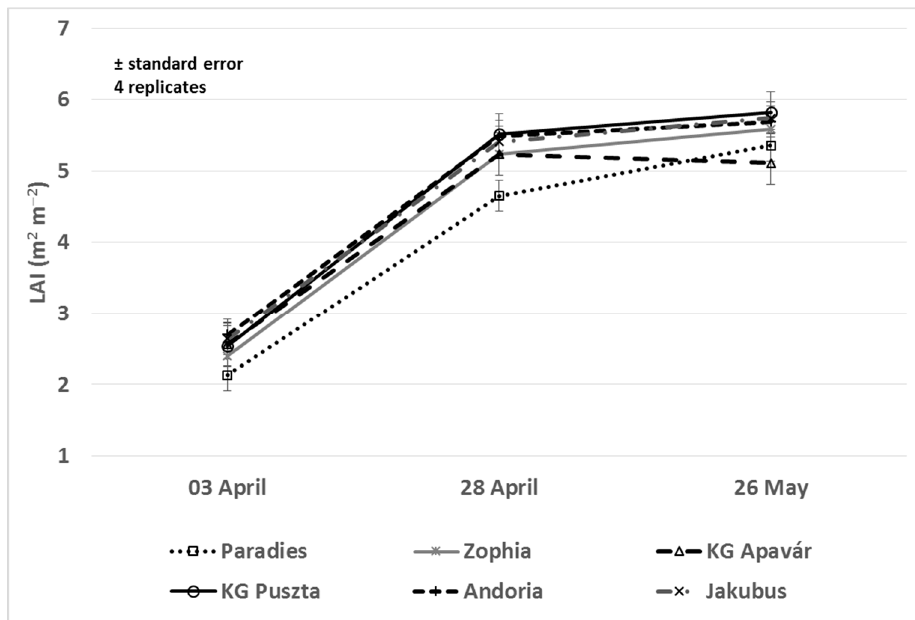
Figure 7. Leaf area index values of winter barley cultivars in the growing season (Debrecen, 2020) Means of N treatments, standard error of means, 4 replicates. Leaf area development of barley plants almost was complete at BBCH 47 − 49 (28 April), statistical analysis did not prove significant differences among the varieties.